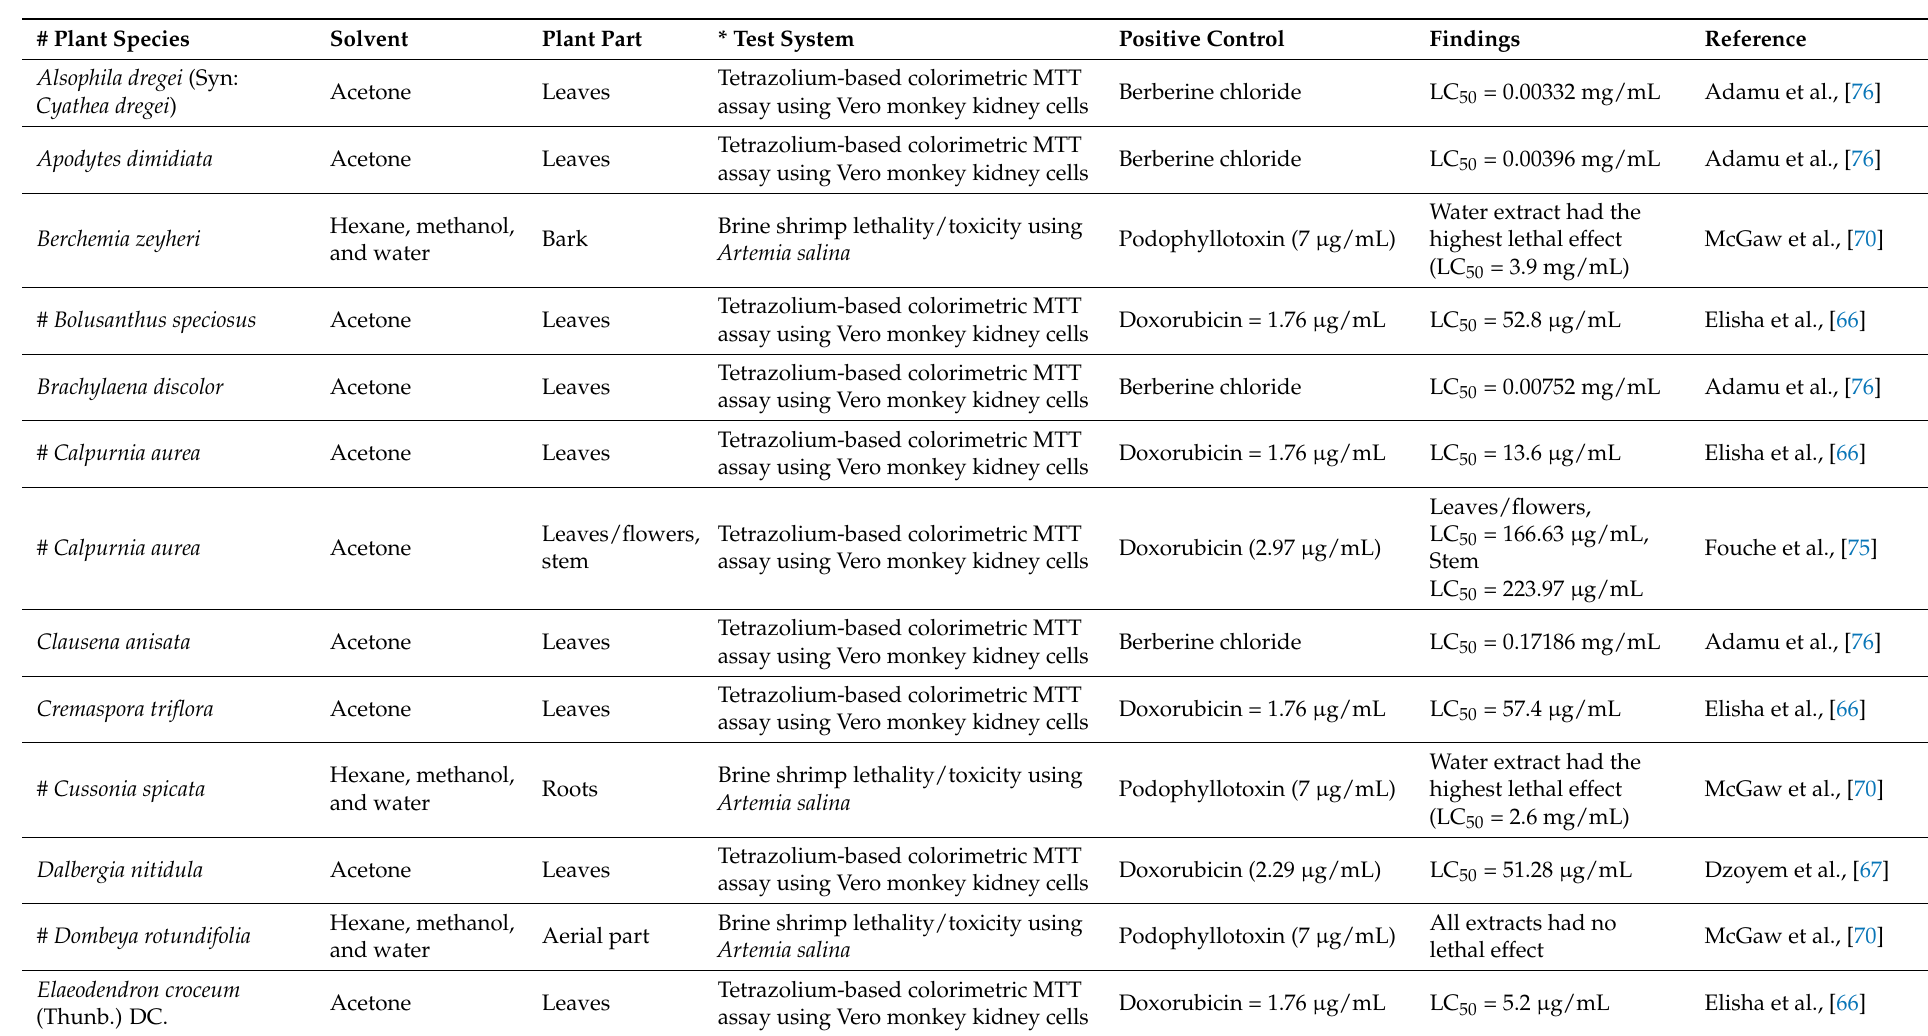
Table 6. Cytotoxic activity of woody plants used for ethnoveterinary purposes in South Africa. # Plant species: denotes woody plants with ethnoveterinary uses in Table 2; * Test